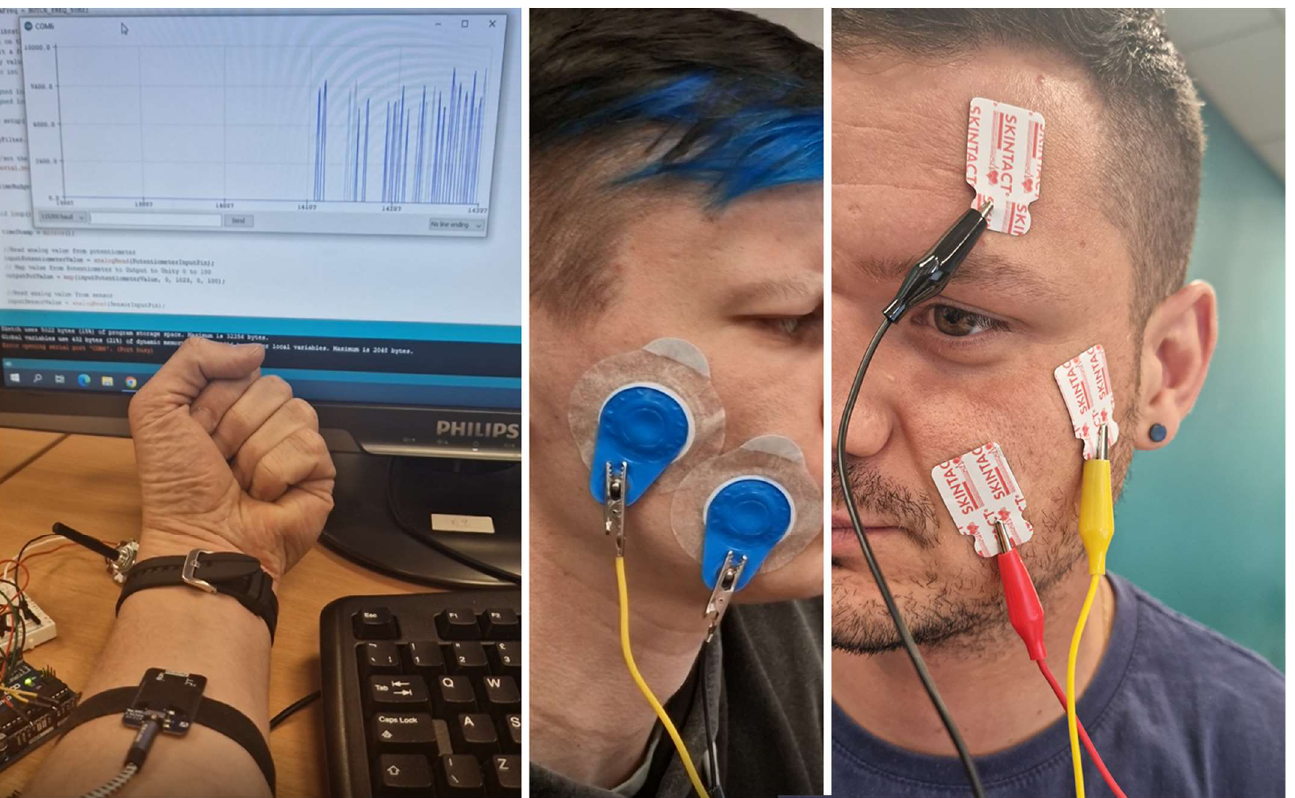
Figure 7. Testing different sensor electrodes on arm and face muscles to check their range of outputs; showing the OyMotion electrode plate on forearm, Ambu Blue ECG electrodes on cheek, over the zygomaticus muscle, and Skintact resting ECG electrodes on cheek with reference electrode on fore- head.